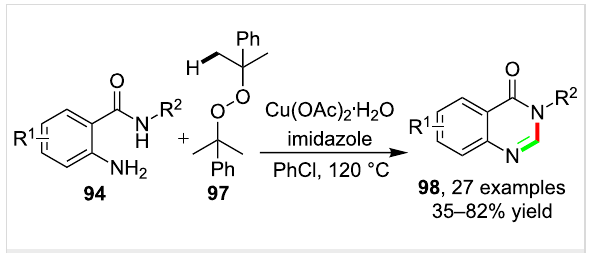
Scheme 25: Dicumyl peroxide-based cascade synthesis of quinazoli-